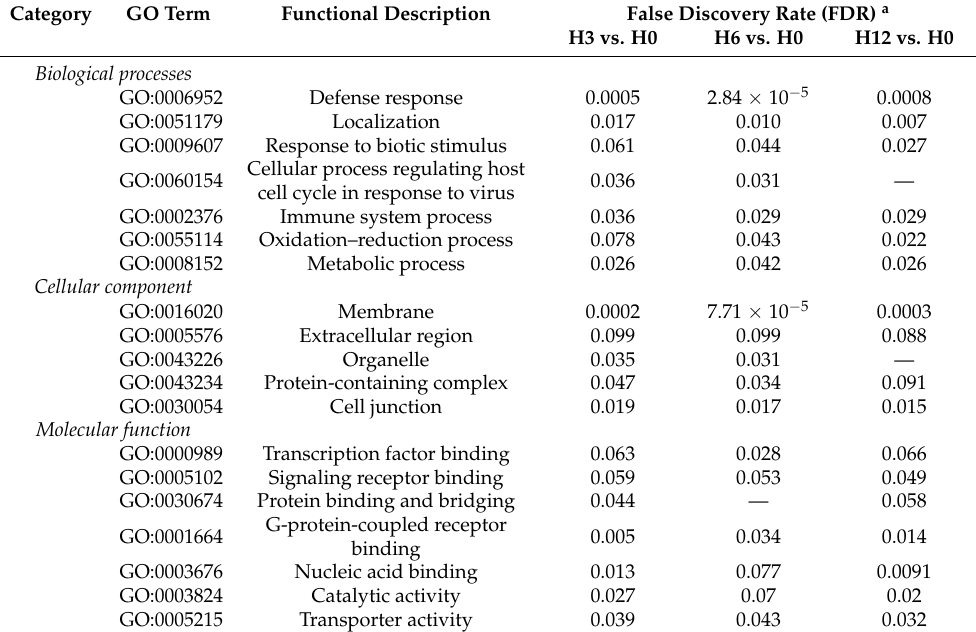
Table 1. The overrepresented terms from GO categories identified in the DEGs in the three compar- isons (H3 vs. H0, H6 vs. H0, H12 vs.